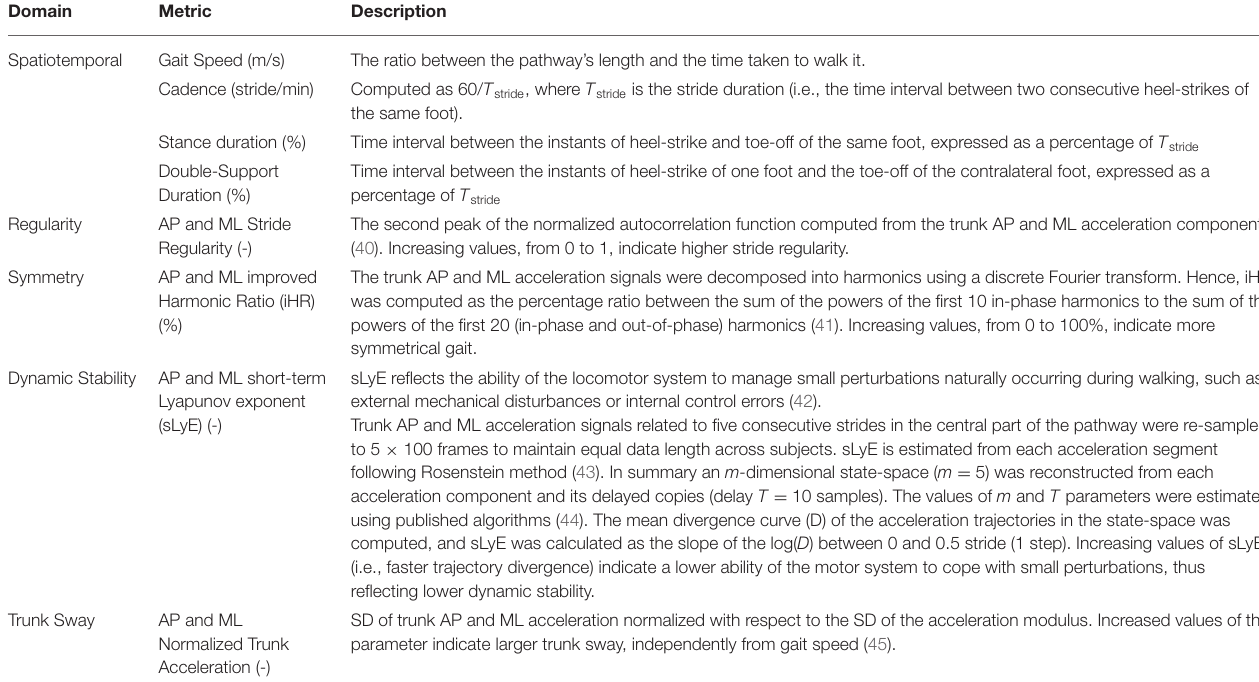
TABLE 1 | Description of the instrumented metrics.